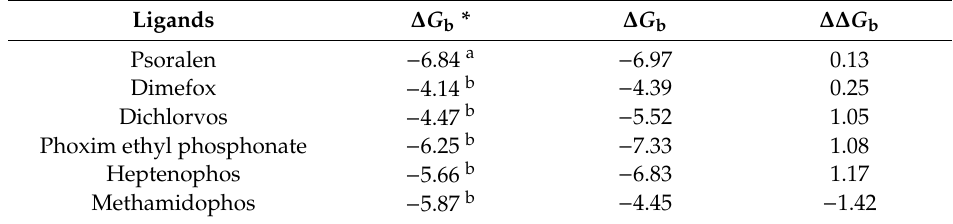
Table A2. Data sheet of comparison of computational